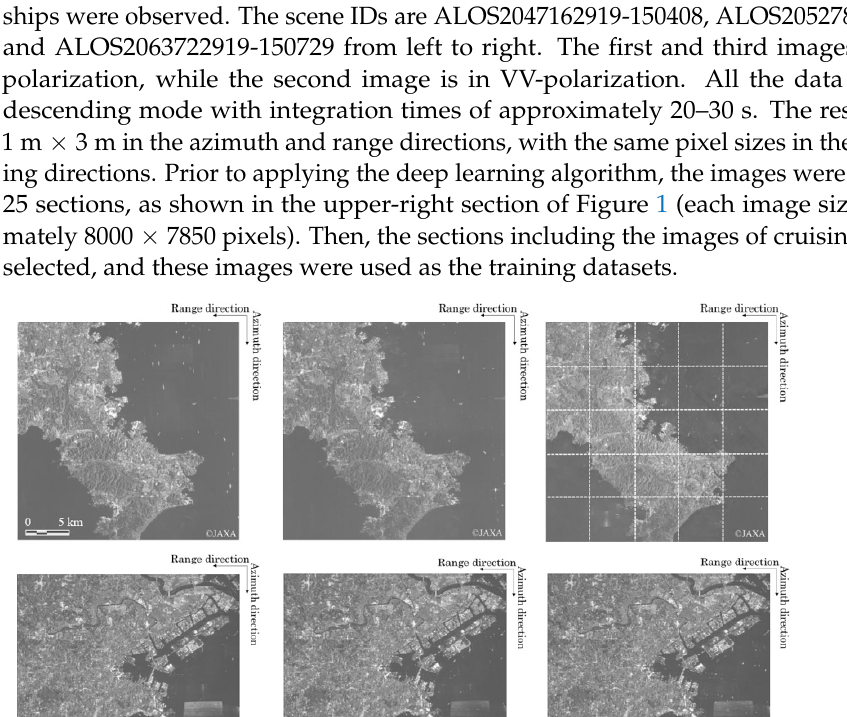
Figure 2. Left : Examples of 4 defocused and azimuth-extended images of cruising ships due to long integration times extracted from Figure 1. Right : Focused image of a stationary ship. The directions are the same as those in Figure 1. 2.2. Deep Learning Method YOLO is a real-time object detection model that has a high accuracy and fast learning speed [26]. In the current research, YOLOv5 [27], a comparatively newer type than the past YOLO series [28–30], was used to build a model for the detection of cruising ships. YOLOv5 also has short learning times and is easy to use. In addition, YOLOv5 has better memory requirements and exportability. In particular, the GPU memory efficiency is high in YOLOv5 during the learning process. The models of S, M, L, and X are the options that exist in YOLOv5, and, in general, the accuracy of the X-model is the highest. In this study, the YOLOv5 X-model was selected for the detection of cruising ships. The network architecture of YOLOv5 is briefly explained as follows: YOLOv5 con- sists of three parts: the backbone, neck, and head. The data are processed to the backbone for feature extraction, to the neck for feature fusion, and to the head for the output. Back- bone extracts the key features from the input images by incorporating a cross-stage partial network [31]. This improves the processing time and ensures a reduced model size. The neck is used to generate feature pyramids, which are helpful for detecting the same object